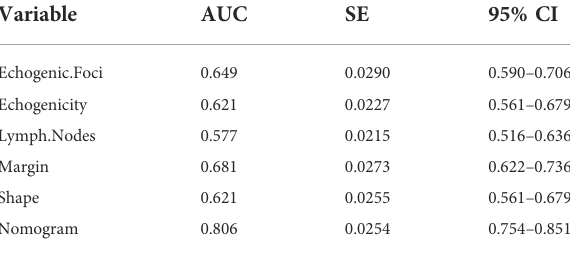
TABLE 2 Predict the AUC value of the